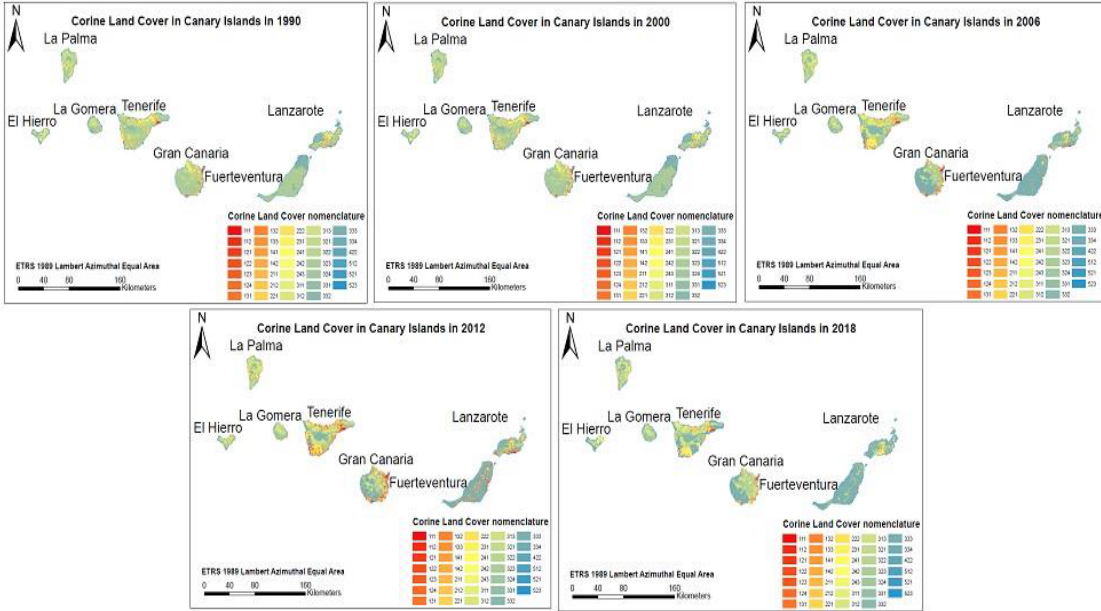
Figure 3. Land use in Canary Islands according to CORINE land-cover nomenclature for level 3 in 1990, 2000, 2006, 2012, and 2018.